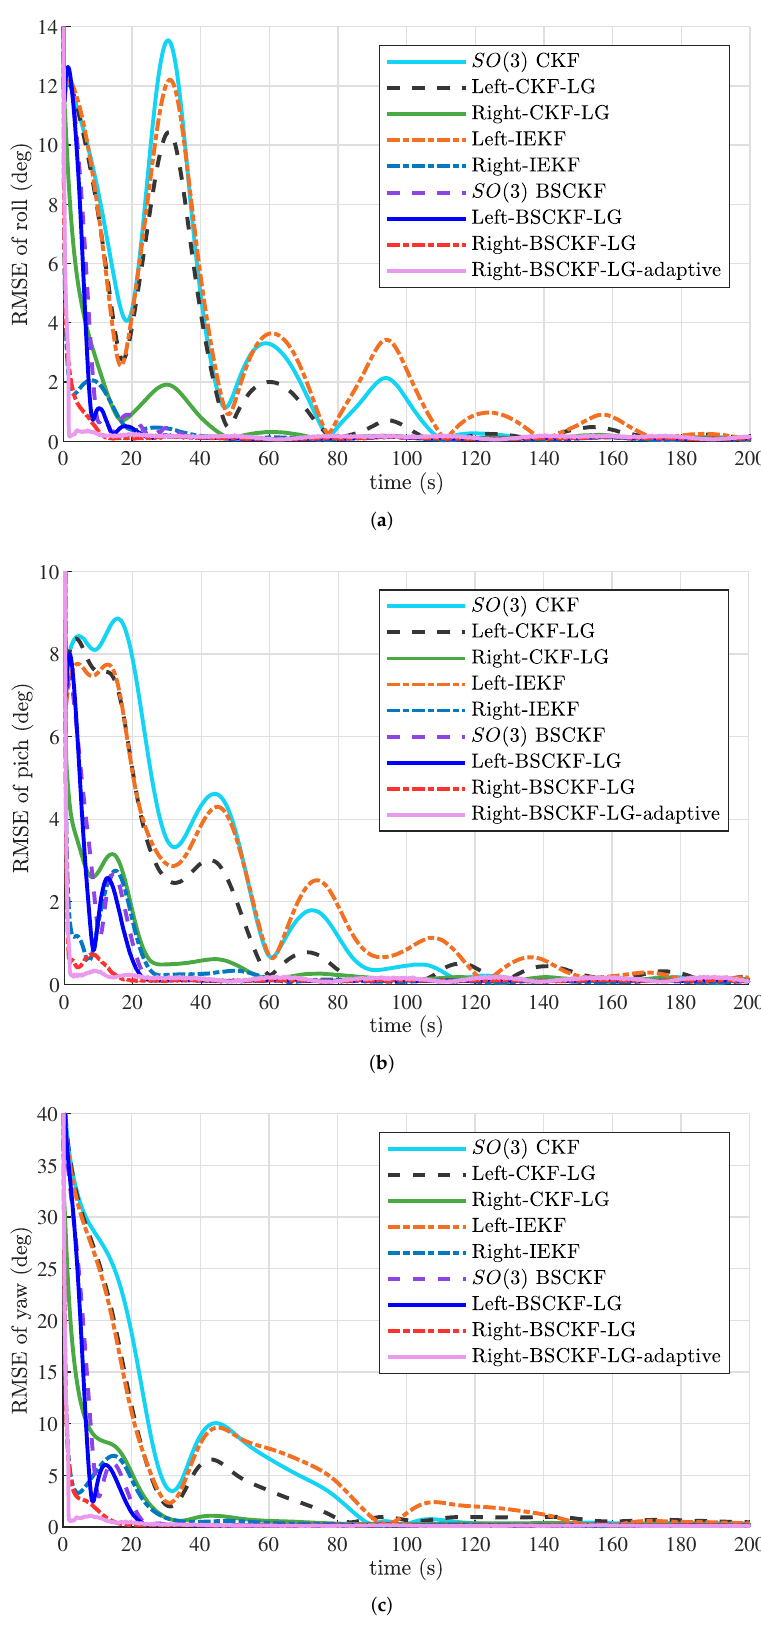
Figure 4. RMSEs of Euler angles in Case 2. ( a ) RMSEs of roll angle; ( b ) RMSEs of pitch angle; ( c ) RMSEs of yaw